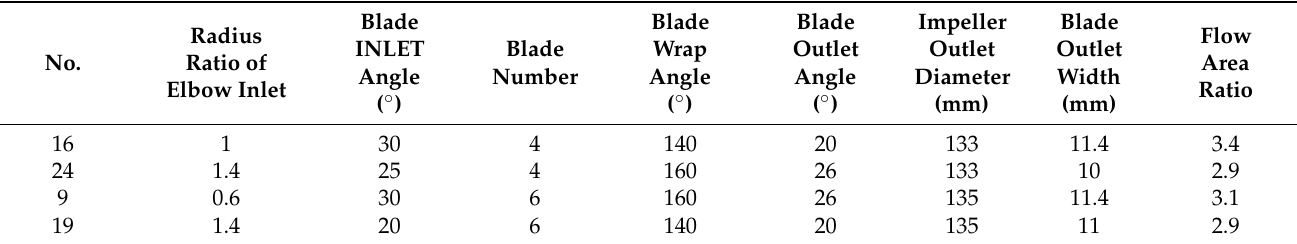
Table 11. Main geometric parameters of typical